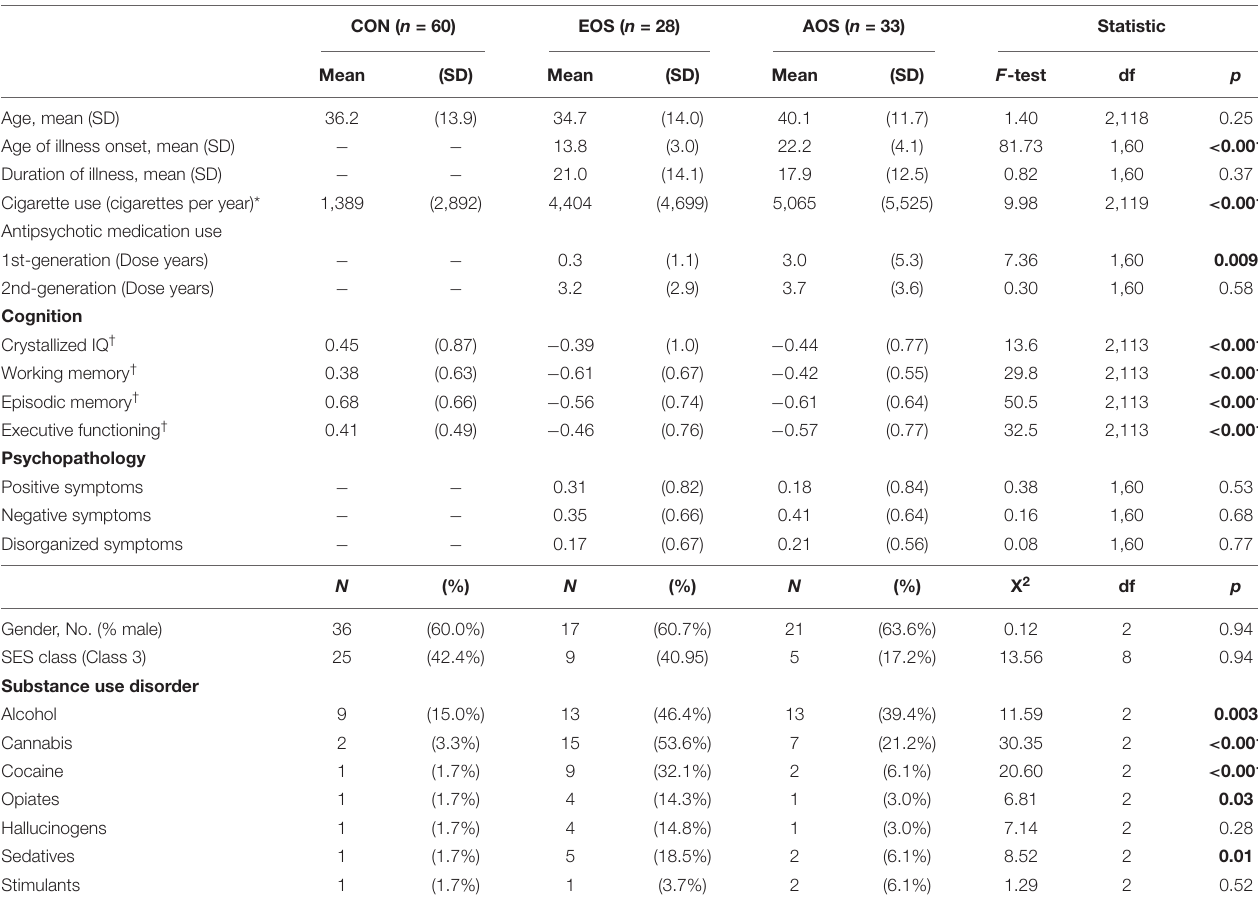
TABLE 1 | Demographic and clinical characteristics of study